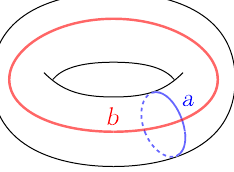
FIG. 13. The solid torus. The boundary of the solid torus is a torus, where two nontrivial cycles a and b are depicted. One might expect to be able to encode two logical qubits in the system; however, any operator supported on the b loop does not admit a symmetric local